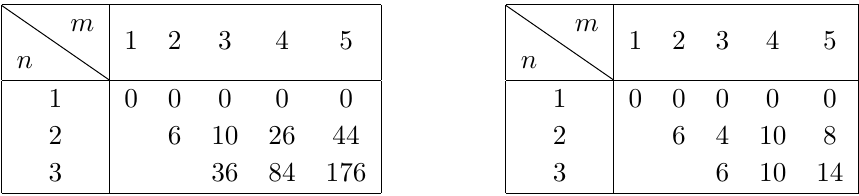
Table 2 . Average SU(2) one-loop dimensions for W m Z n with m (cid:21) n , in the unit of N c g 2 Left table shows the sum over all U( N c ) multi-trace operators, and Right table shows the sum over all single-trace SU(2) highest weight